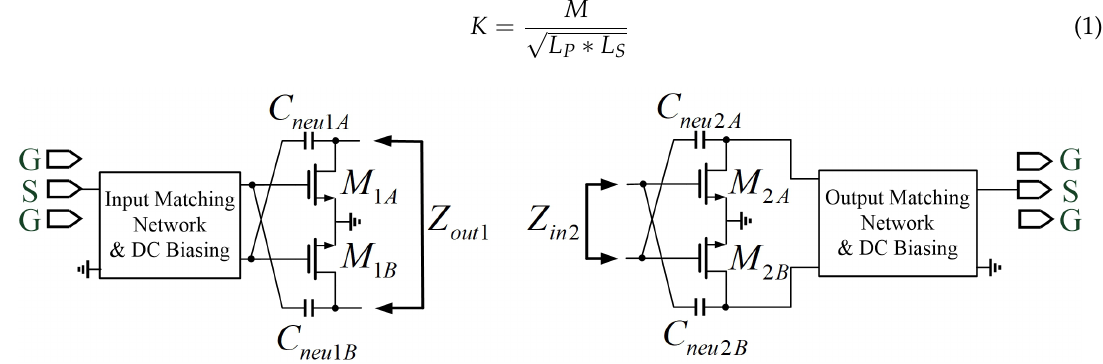
Figure 5. Schematic about impedance extraction for inter-stage matching.